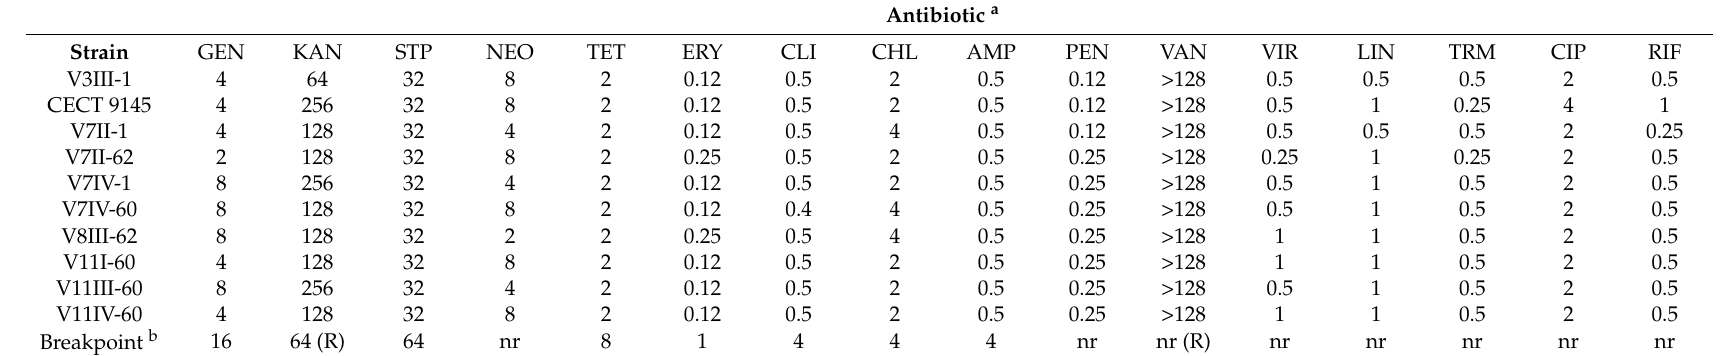
Table 5. The minimal inhibitory concentration (MIC, mg/mL) values of 16 antibiotics a to the L. salivarius